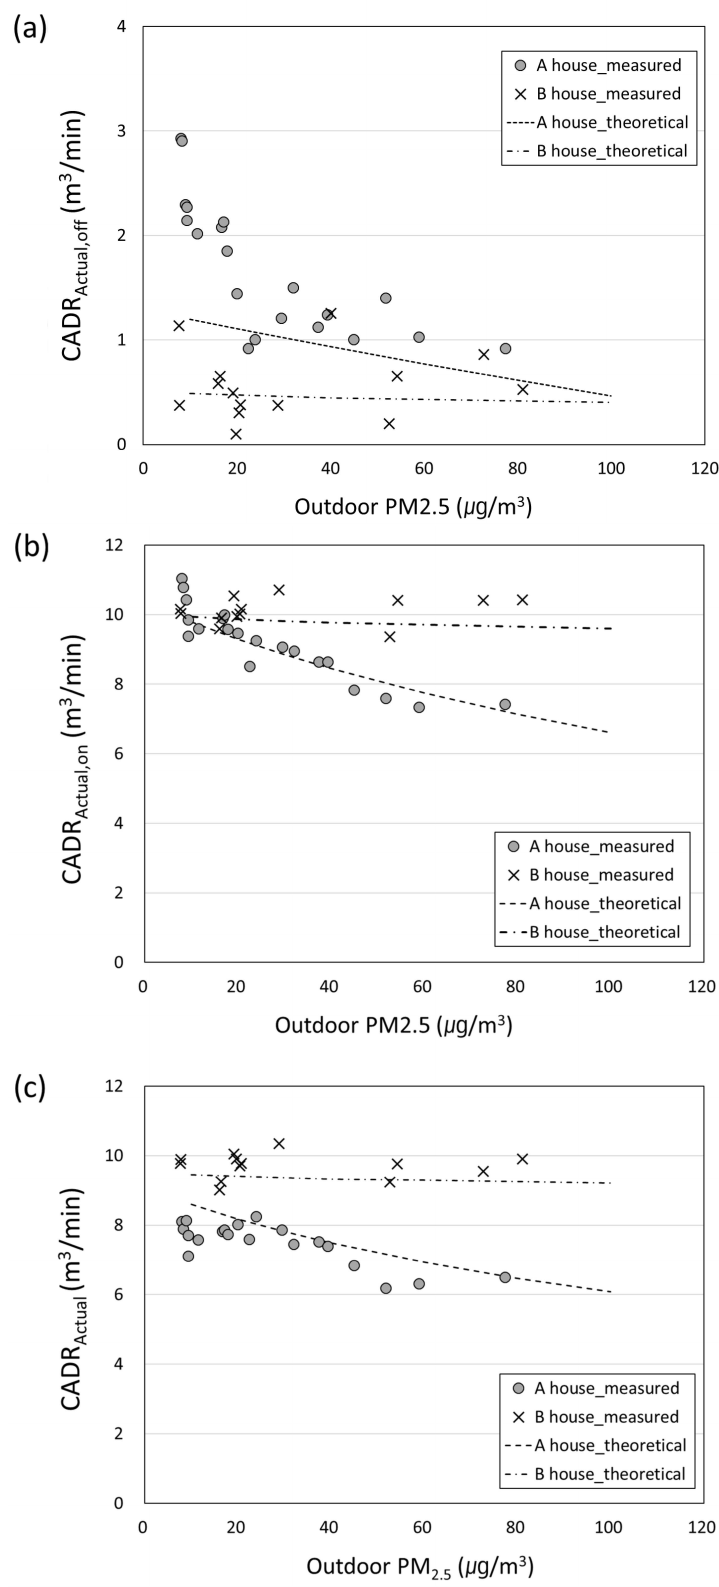
Figure 7. Experimental and theoretical CADR Actual of an air purifier for 0.3–1.0 µ m particles at different outdoor PM 2.5 concentrations. ( a ) is acquired with an air purifier off (CADR Actual,off ) ( b ) is with an air purifier on (CADR Actual,on ) and ( c ) is CADR Actual (=CADR Actual,on − CADR Actual,off